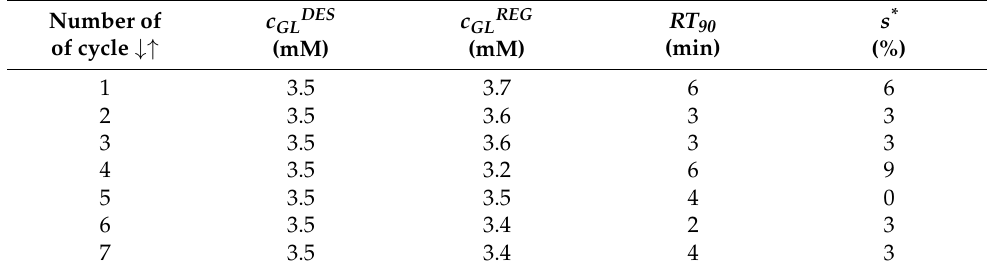
Table 3. Response times and deviation from desired glucose concentration during feedback control of glucose concentration in stationary phase of cultivation of Saccharomyces cerevisae. RT 90 Number of c GLDES c GLREG of cycle ↓↑ (mM) (mM)